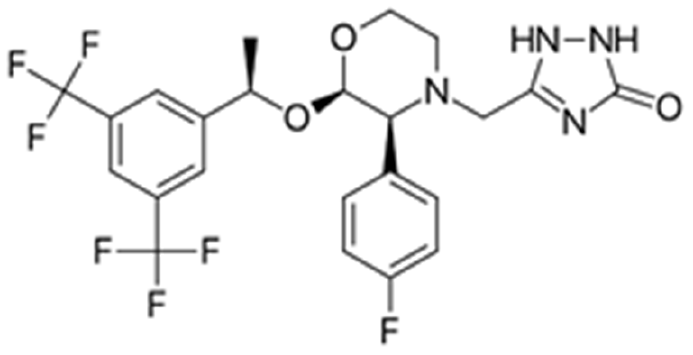
Figure 1. Chemical structure of aprepitant.